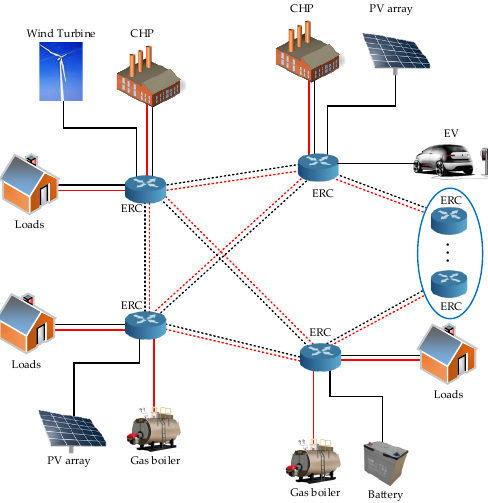
Figure 1. Structure of energy internet with energy routing centers.